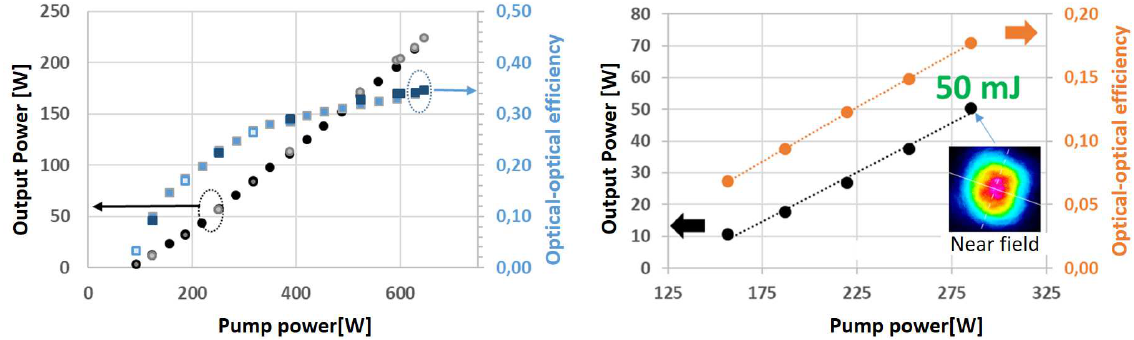
Fig. 1 Output power and efficiency as a function of the pump power in (a) fundamental mode CW operation and (b) seeded regenerative operation at 1